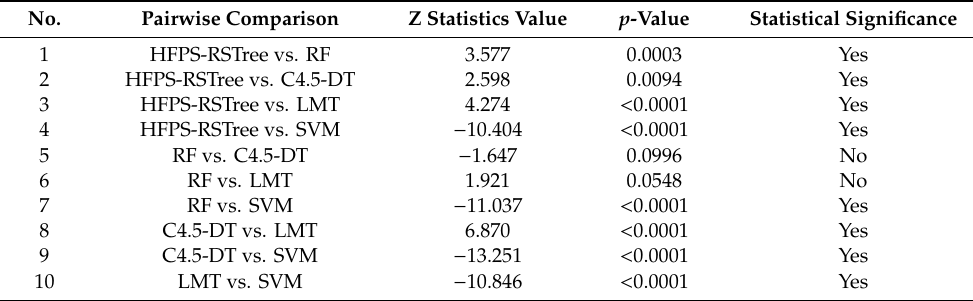
Table 4. Wilcoxon rank-sum test for the five flash flood